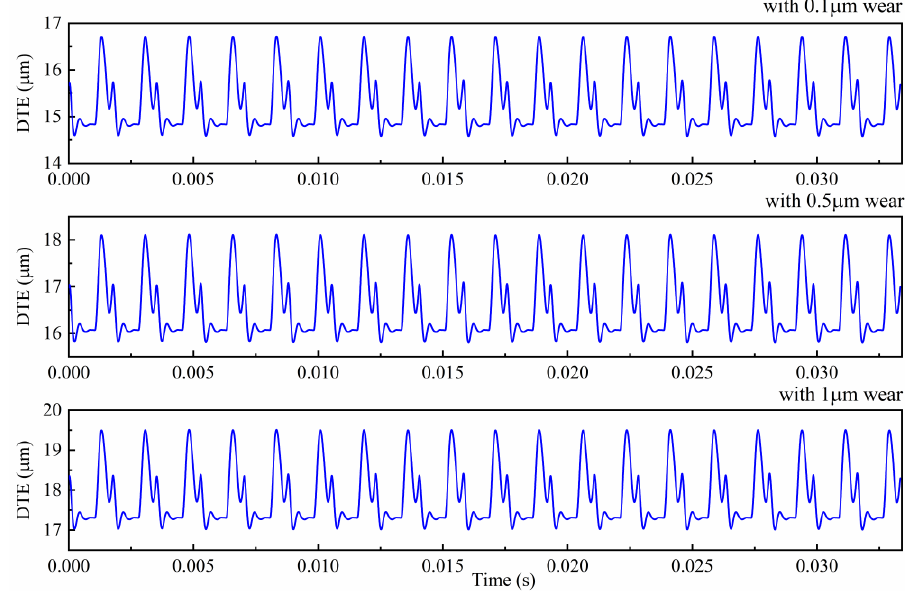
Figure 4. Dynamic transmission error (DTE) with different wear severities.